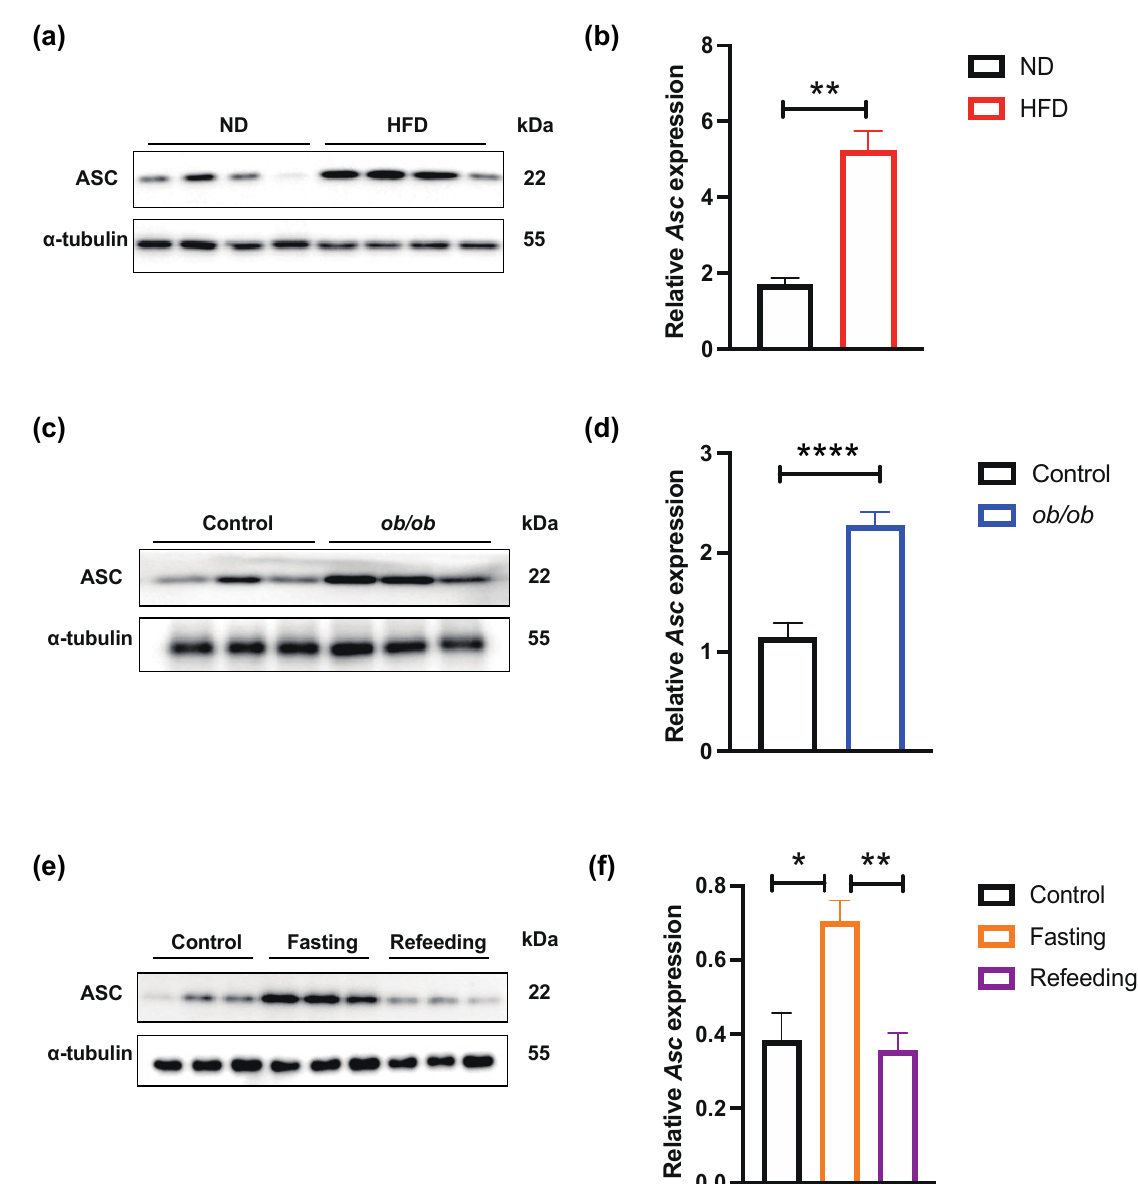
Figure 1. ASC expression in subcutaneous adipose tissue was increased in obese and fasting male mice. ( a , b ) Western blot and RT-qPCR analysis of expression of ASC in SAT from ND and HFD mice (n = 4/group) (Black-ND mice, Red-HFD mice); ( c , d ) Western blot and RT-qPCR analysis of SAT ASC expression in ob / ob mice (n = 9/group) (Black-Control mice, Blue- ob / ob mice); ( e , f ) Western blot and RT-qPCR analysis of SAT ASC expression in three groups of WT C57 mice were either not treated (Control), fasted for 24 h (Fasting), or followed by refeeding for 24 h (Refeeding) (n = 6/group) (Black-Control mice, Orange-Fasting mice, Purple-Refeeding mice); * p < 0.05, ** p < 0.01, **** p < 0.0001.